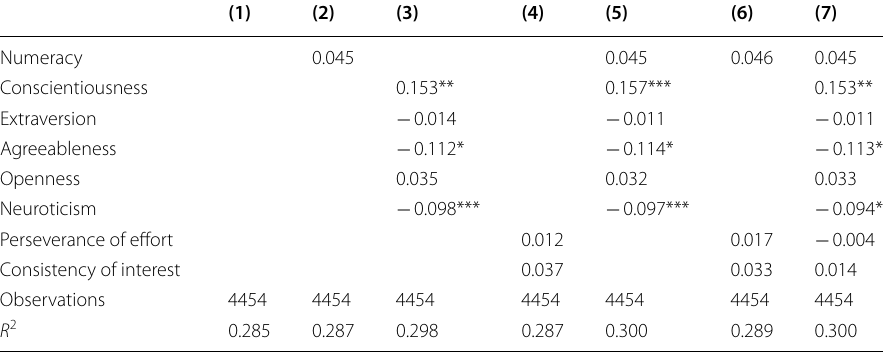
* p < 0.05, ** p < 0.01, *** p < 0.001. Control variables: age, age square, gender, years of education. Dependent variable, numeracy and non‑cognitive skills are standardised. Full estimation results are presented in Additional file 3: Table